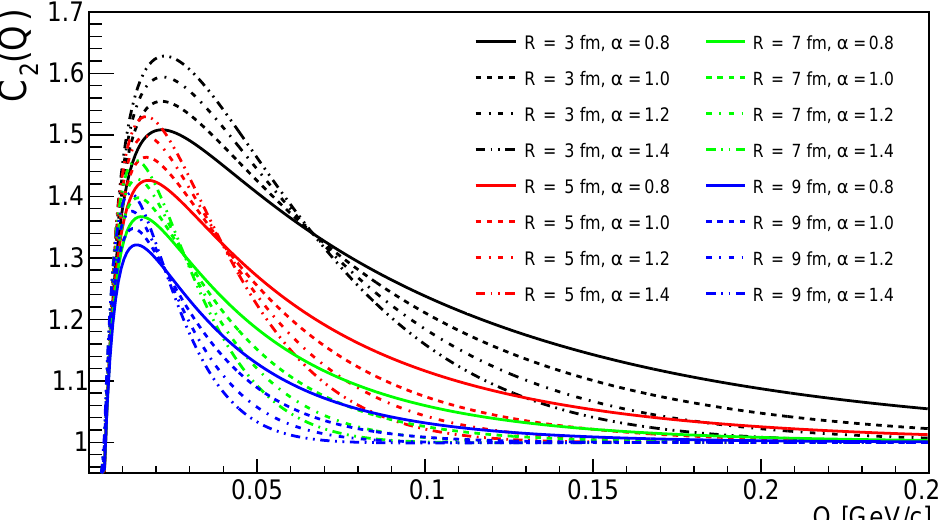
Figure 3. Example correlation functions, based on Equation (32), for different values of parameters R and α .